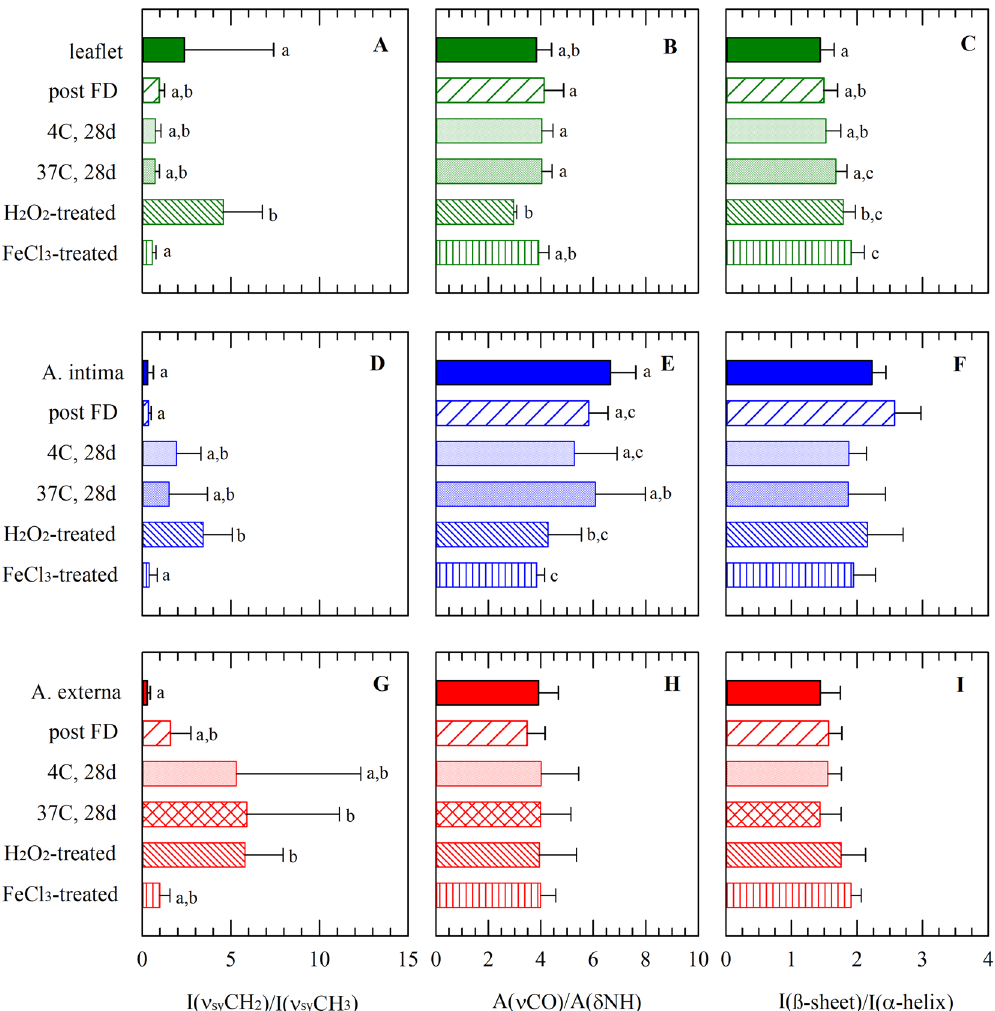
Figure 4. Effects of freeze-drying, dried storage, and induced oxidative damage (i.e., treatment with H 2 O 2 or FeCl 3 ) on infrared spectral fingerprints taken from layers of the aortic leaflet and trunk; expressed as different band ratios. Spectral characteristics were determined for the leaflet ( A – C ; green bars), intima ( D – F ; blue bars) and externa ( G – I ; red bars) artery layer; for specimens before (filled bars) and after freeze-drying (bars with upward diagonal lines), after 1 month storage at 4 °C (dotted bars) and 37 °C (bar with diamonds), as well as specimens exposed to H 2 O 2 (bar with downward diagonal lines) and FeCl 3 -treatment (bar with horizontal lines). From normalized second derivative spectra in the 2900–2830 cm −1 region, band intensity ratios of the symmetric stretching vibrations of the CH 2 and CH 3 peaks [I(ν sy CH 2 )/ν sy CH 3 )] were determined ( A , D , G ). From original spectra the absorbance band areas of the C = O stretching (at ~ 1640 cm −1 ) and N–H bending (at ~ 1560 cm −1 ) vibration were determined, and their ratio [A(νCO)/A(δNH)] was calculated ( B , E , H ). From second derivative spectra in the 1700–1600 cm −1 region, band intensity ratios of the bands at ~ 1650 and ~ 1630 cm −1 , representing respectively α-helical and β-sheet structures, [I(β-sheet)/I(α-helix)] were determined ( C , F , I ). Mean ± standard deviations were calculated from six different spectra, while statistically significant differences are indicated with different letters ( p <